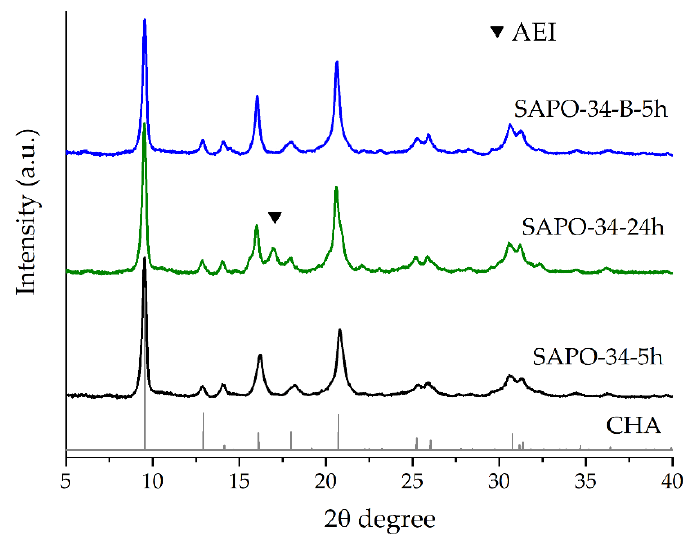
Figure 2. XRD patterns of synthesized SAPO-34. Triangle indicates AEI (SAPO-18) structure.